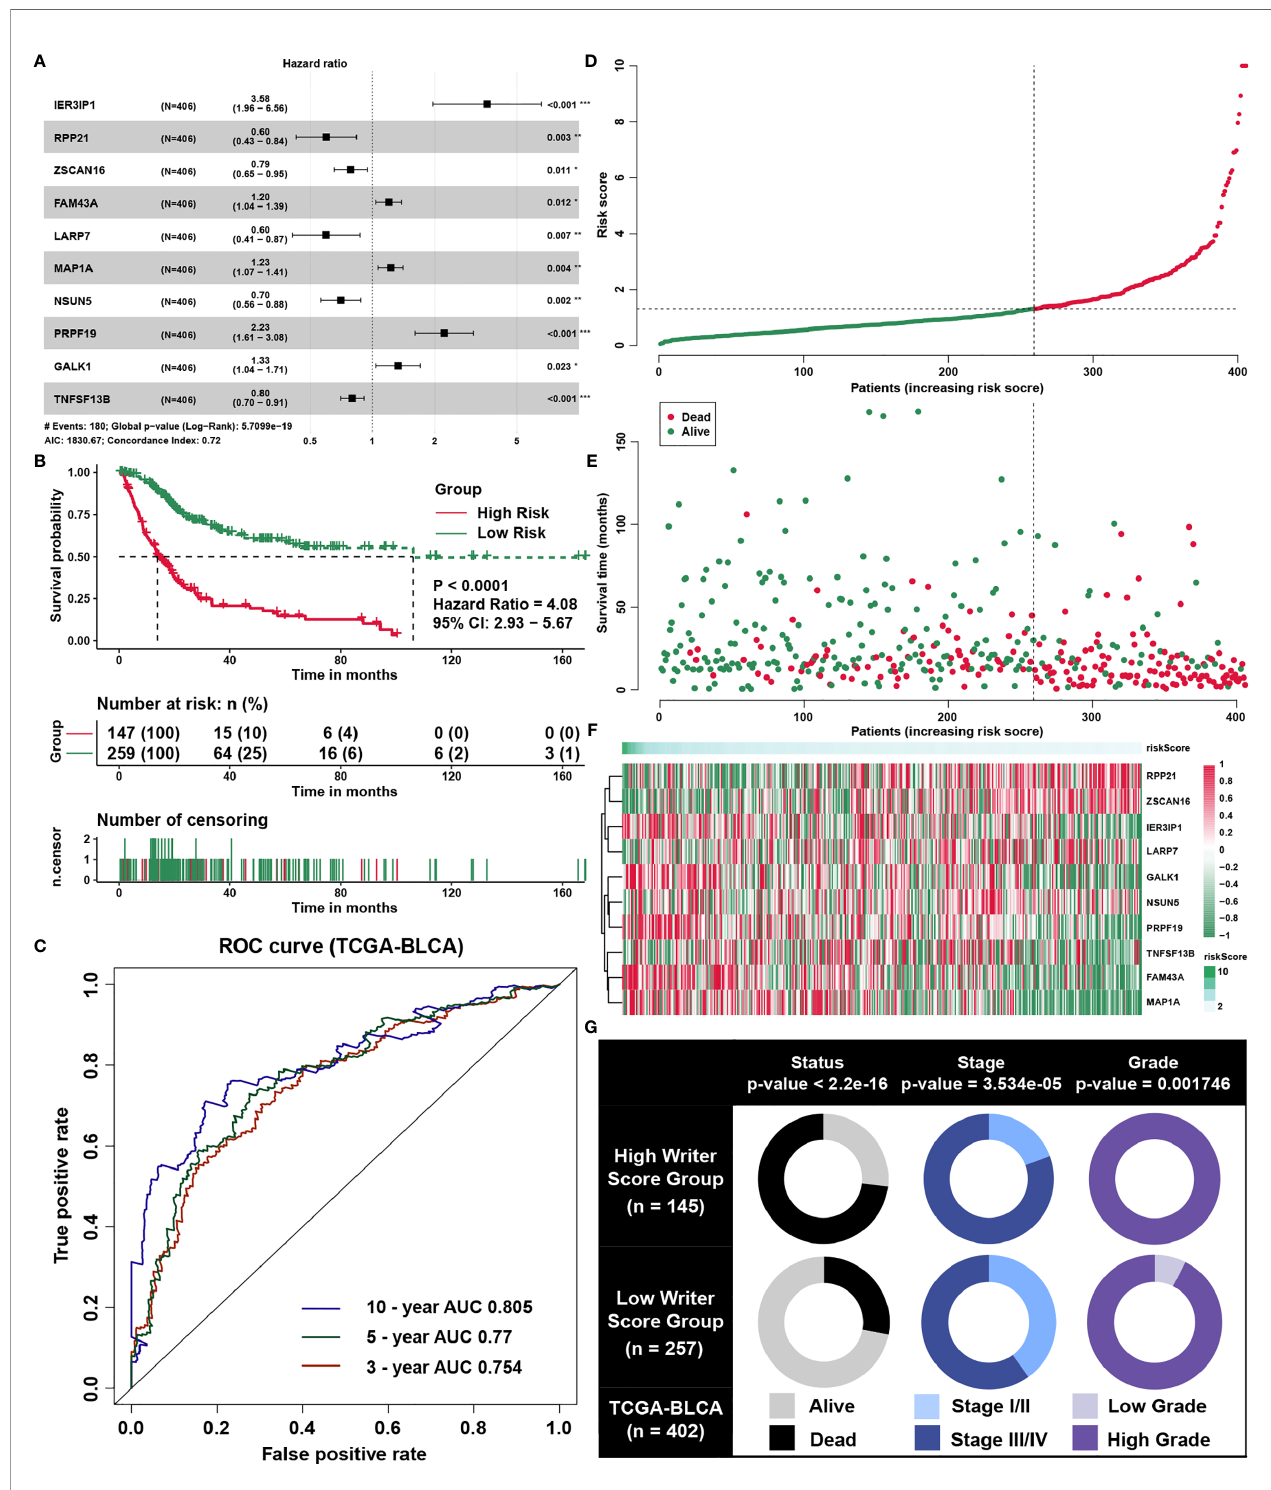
FIGURE 3 | Construction of a writer-related gene signature of BLCA. (A) Hazard ratio and P ‐ value of constituents involved in multivariate Cox regression and some parameters of the gene signature. (B) Kaplan ‐ Meier survival curves plotted to estimate the overall survival probabilities for the low ‐ risk versus high ‐ risk group. (C) ROC curves plotted for 3 ‐ , 5 ‐ and 10 ‐ y overall survival. (D) The gene signature risk score distribution. (E) The vital status of patients in the high ‐ risk and low ‐ risk groups. (F) Heatmap of the expression pro fi les of members in the gene signature. (G) The correlations between risk score and clinical parameters. Chi-square tests were used to test for statistical correlations. *P < 0.05, **P < 0.01, ***P <